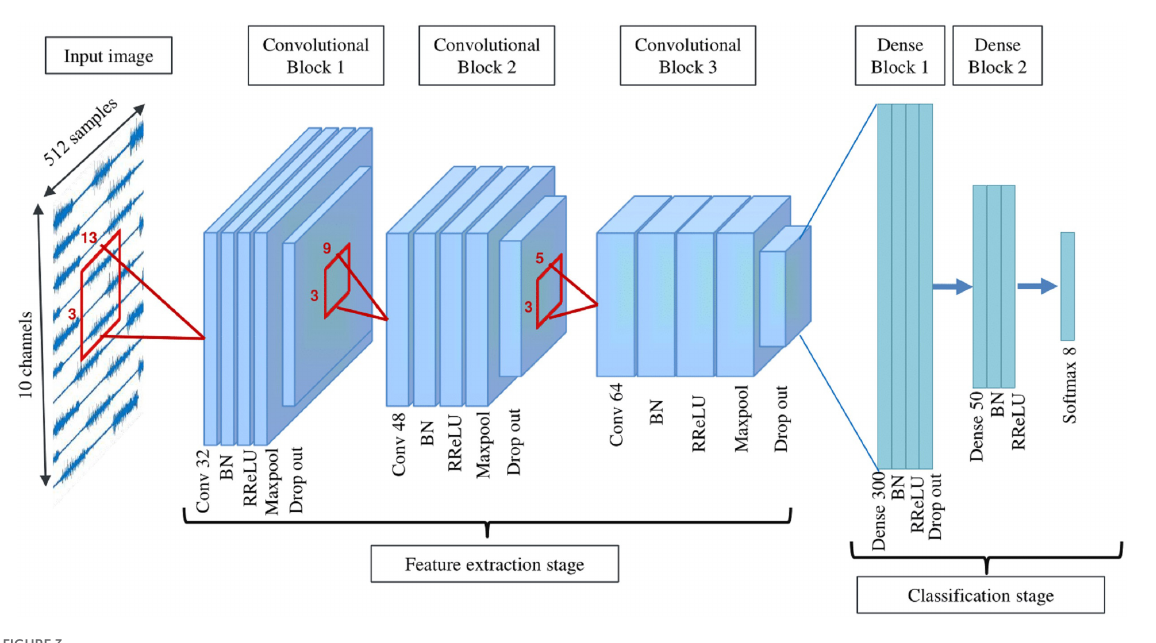
technique that performs input normalization in each training